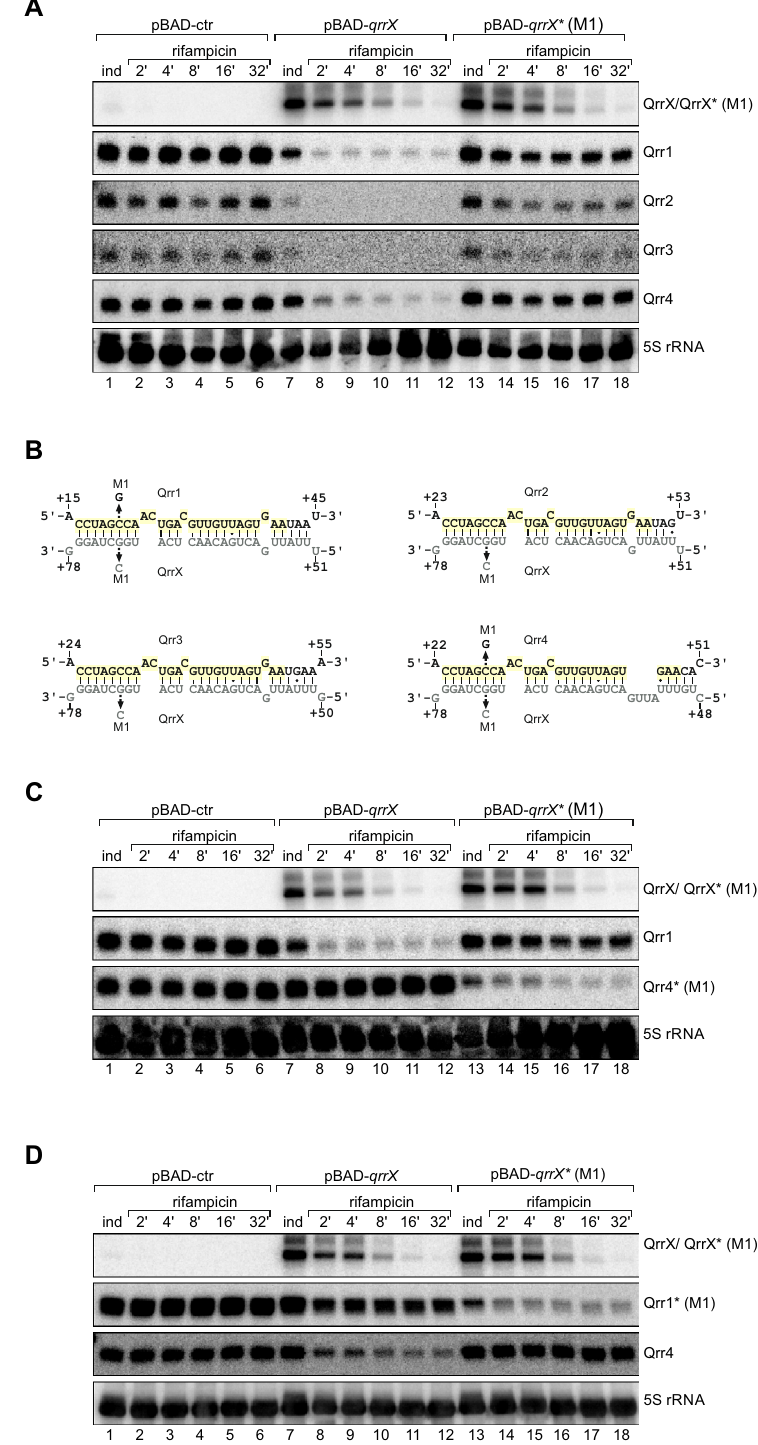
Fig. 3 | QrrX base-pairs with and destabilizes the Qrr1-4 sRNAs. A Stability of Qrr1-4 upon induction of QrrX. V. cholerae wild-type cells harboring either pBAD- qrrX , pBAD- qrrX * (M1) or an empty control plasmid (pBAD-ctr) were cultivated in LB medium to OD600 of 0.2. Expression of QrrX or QrrX* (M1) was induced with L-arabinose and rifampicin was added to monitor RNA stability. Northern blot analysis shows QrrX/QrrX* and Qrr1-4 levels at the indicated time points. 5S ribosomal RNA was used as loading control. The experiment was performed with three independent biological replicates ( n =3). B Predicted base-pairing interac- tionsbetweenQrrXandQrr1-4.ThesequencethatisidenticalinQrr1-4ismarkedin yellow.ArrowsindicatethepointmutationsinQrrX,Qrr1andQrr4testedinFig.3A,